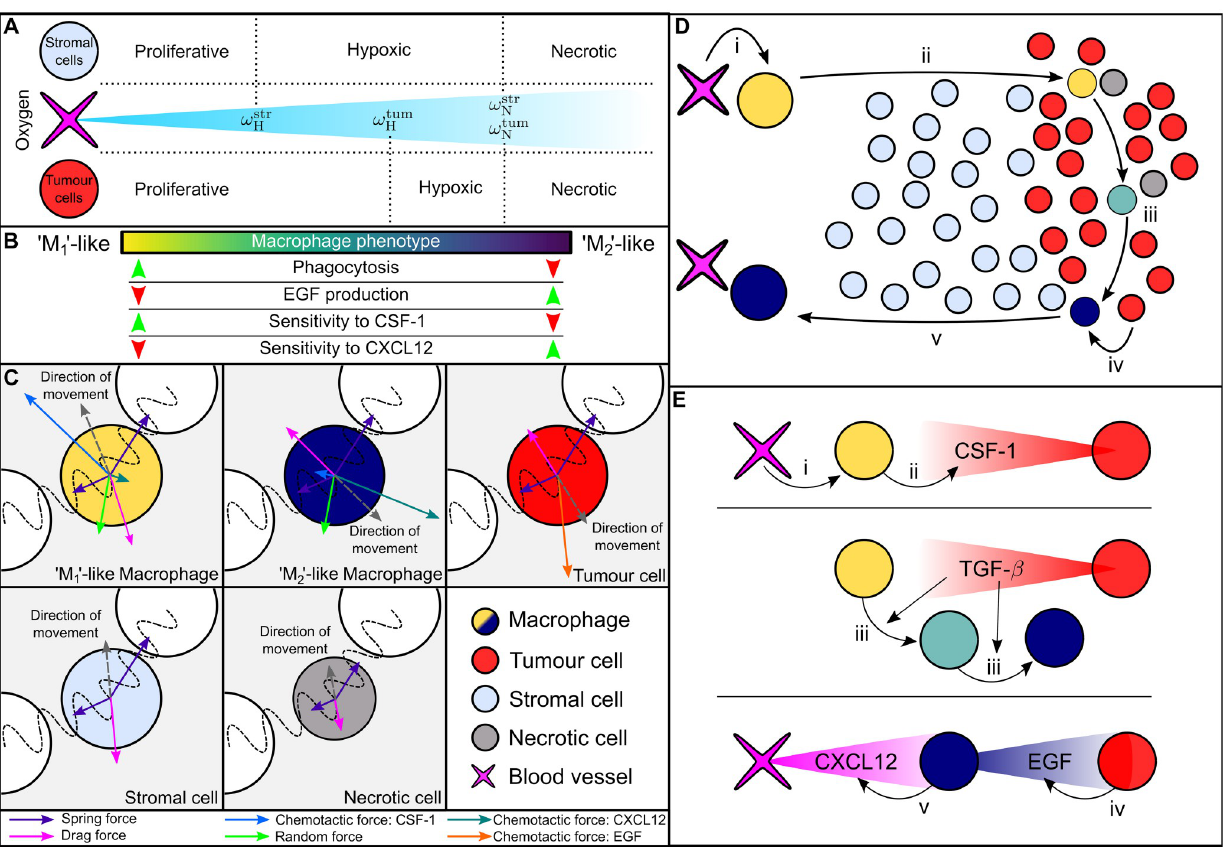
Fig 2. Schematic summarising the key interactions that are included in the agent based model. A: Oxygen is supplied by blood vessels and consumed by stromal cells and tumour cells. Cell-cycle progression is determined by a cell’s local oxygen concentration: a cell may be ‘proliferative’ (and progress through its cell cycle), ‘hypoxic’ (the cell cycle is temporarily paused until oxygen concentrations return to a sufficiently high level) or ‘necrotic’ (the cell becomes necrotic cell and degrades). Cell cycles also pause if there is insufficient space available for proliferation. B: Macrophage behaviour depends on phenotype p , modulating their rates of tumour cell killing, EGF production, and chemotactic sensitivity to gradients of CSF-1 and CXCL12. C: Forces acting on different cell types. Macrophages are subject to mechanical forces due to interactions with nearby cells, and random forces which simulate their exploration of their environment as highly motile cells. Macrophages also experience chemotactic forces that are directed up spatial gradients of CSF-1 and CXCL12, and whose magnitude depends on p . Tumour cells experience mechanical forces due to interactions with neighbouring cells, and chemotactic forces in the direction of increasing EGF. Stromal cells experience mechanical forces due to interactions with neighbouring cells. Necrotic cells experience these interaction forces, which decrease in magnitude as they decrease in size. All cells experience a drag force. D: Summary of the phases of macrophage- mediated tumour cell migration in our ABM. i) M 1 macrophages extravasate from blood vessels in response to CSF-1. ii) M 1 macrophages migrate into the tumour mass in response to CSF-1, where they may kill tumour cells. iii) Exposure to TGF- β causes macrophages to adopt an M 2 phenotype. iv) M 2 macrophages produce EGF, which acts as a chemoattractant for tumour cells. v) M 2 macrophages migrate towards blood vessels, in response to CXCL12 gradients. E: Schematic summarising the sources of CSF-1, TGF- β , EGF and CXCL12 in our model, and their interactions with cells, as described in steps i- v of panel